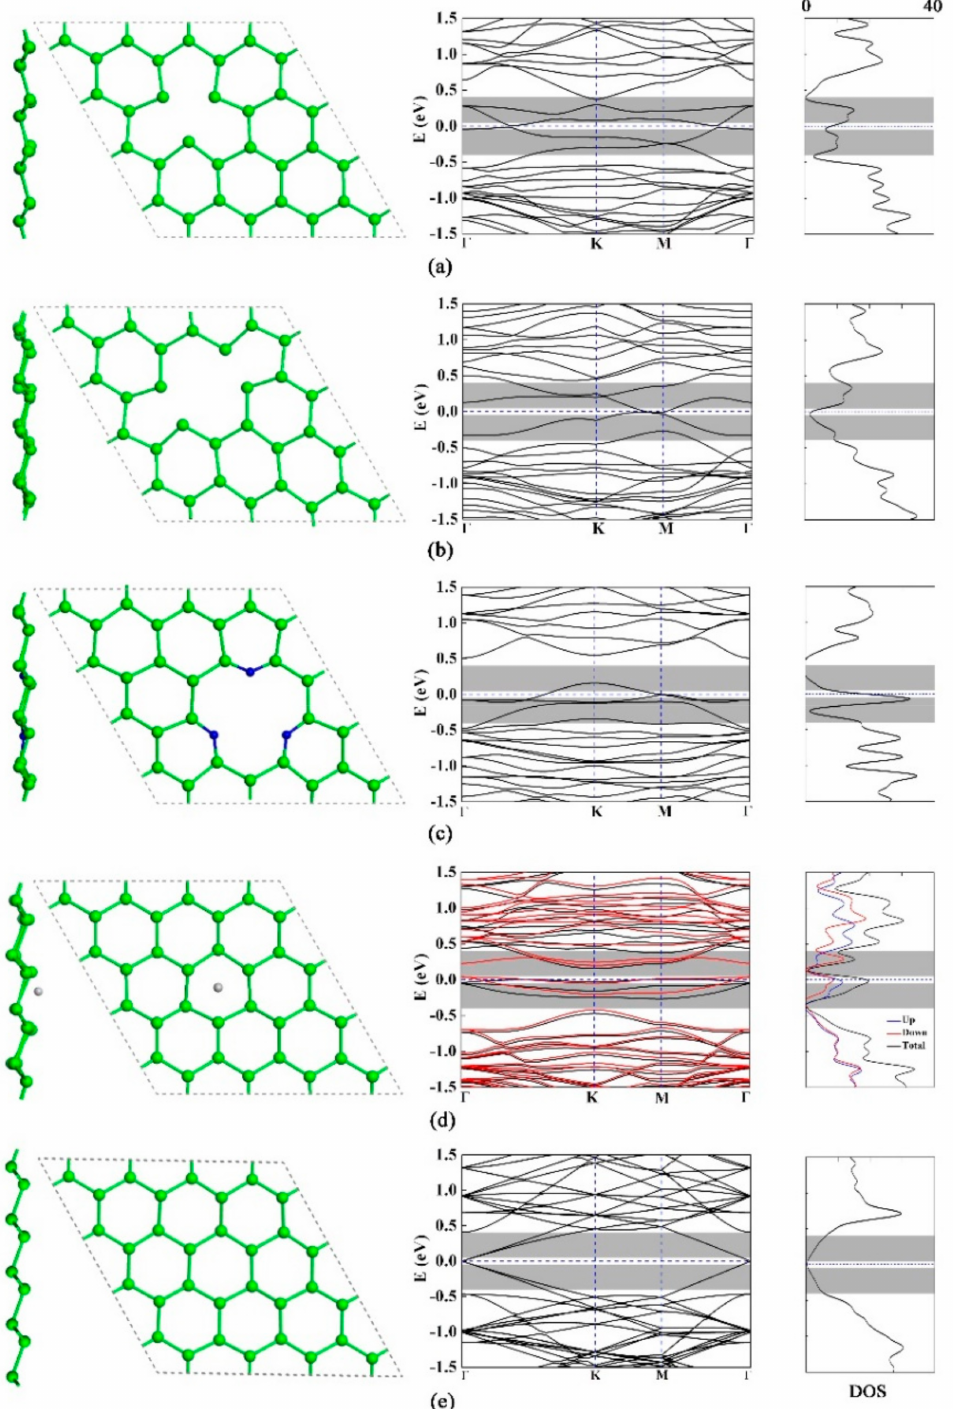
Figure 2. Atomic structures (left) of proposed germanene-based models, band structure (middle), and density of states (right) of the ( a ) single-vacancy, ( b ) double-vacancy, ( c ) triple-N doped with single-vacancy germanene, and ( d ) Ti atom adsorbed on pristine germanene with hollow site and ( e ) pristine germanene. The Fermi levels were indicated by the blue and horizontal dashed